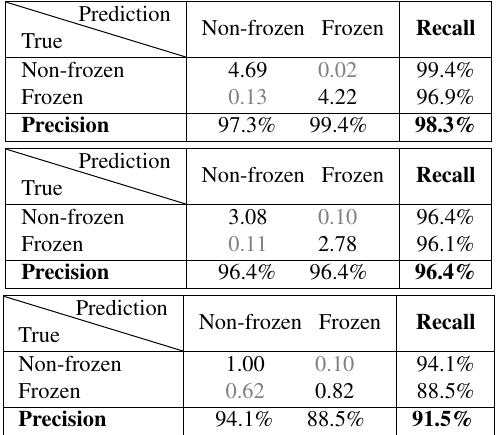
Table 5: Results for lake Sils (top), Silvaplana (middle), and St. Moritz (bottom). Confusion matrices are shown for the leave-one-lake-out cross-validation experiment. Units are in millions of pixels, except for precision, recall, and accuracy (bottom right cell in each